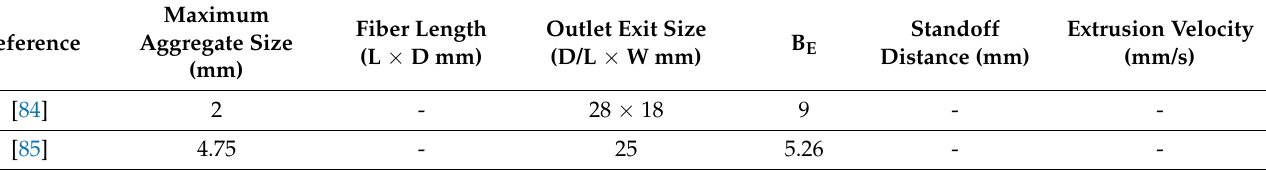
Table 5. Examples of maximum aggregate size, fiber length and D exit adopted in E3DCP